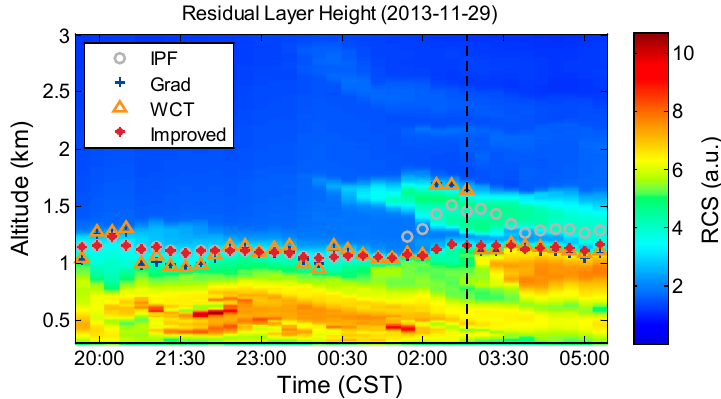
Figure 2. Range-corrected signal (RCS) measured by elastic Lidar from 20:00, 29 November 2013 to 05:20, 30 November 2013 CST; RLHs were determined with ideal profile-fitting (IPF), gradient (Grad), wavelet covariance transform (WCT), and improved method with RCS.